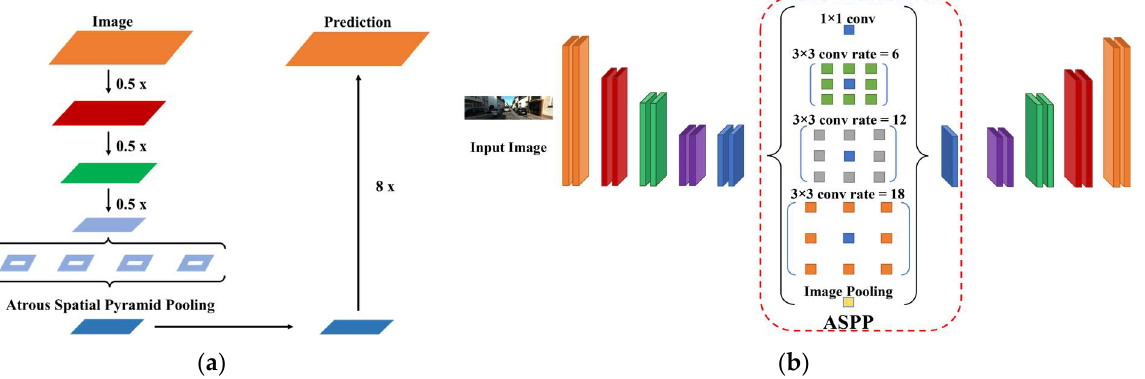
Figure 11. CNN with ASPP. ( a ) Classical CNN structure, ( b ) encoder–decoder CNN structure.